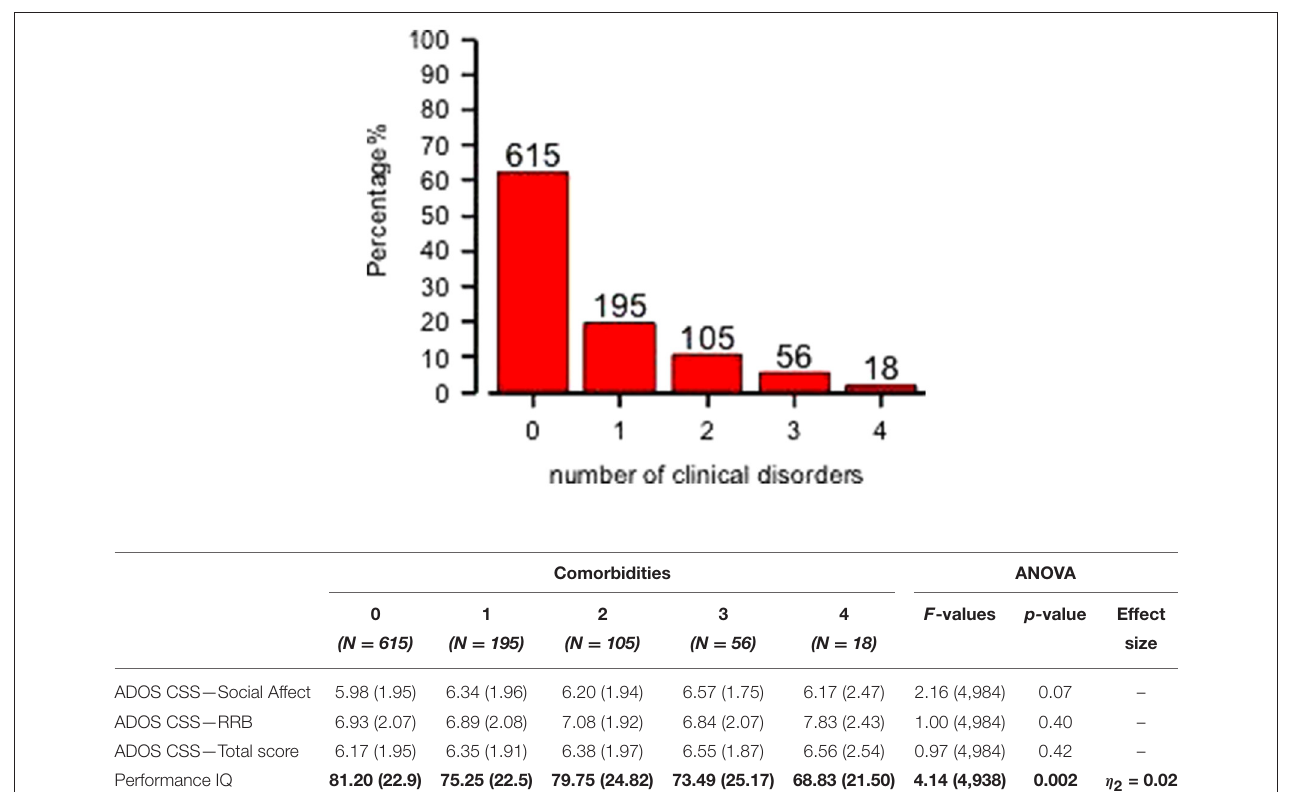
FIGURE 1 | Distribution of mono– and multi–comorbidity across the whole sample and clinical comparisons. One–way ANOVA on ADOS scores and Performance IQ (means and SD) for all comorbidities groups are reported. Significant comparison are highlighted in bold.